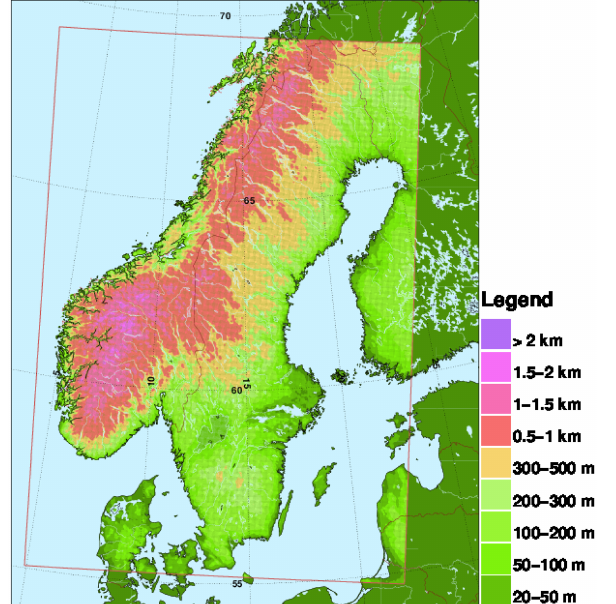
Figure 2. NWP model domain. Colours represent topography de- scribed in